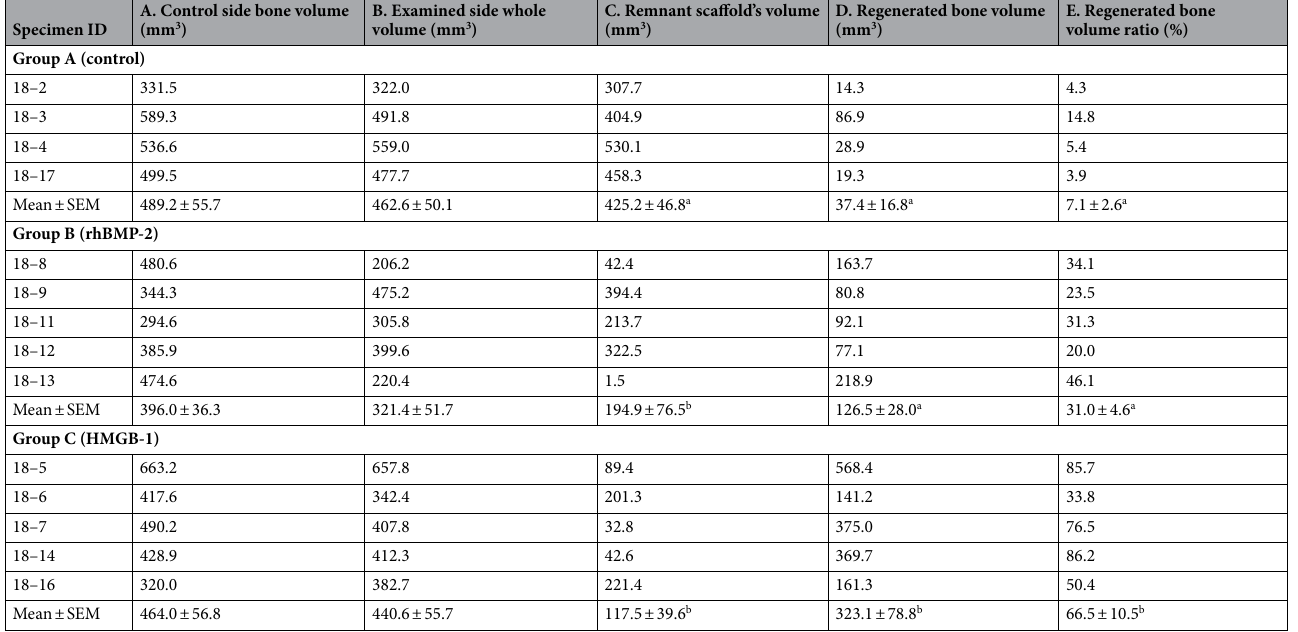
Table 1. Distribution of the values of individual specimens retrieved using micro-computed tomography (CT) analysis for each group. Values are represented as mean ± SEM. Mean values within a column with